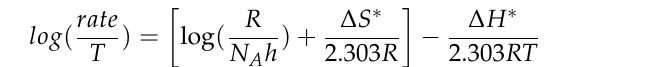
where Δ𝐼𝐸 ((cid:2871)(cid:2868)°(cid:2879)(cid:2874)(cid:2868)°)(cid:2887) % represents the overall decline in the IE % with increasing tempera- ture from 30 °C to 60 °C and may provide a good criterion for the stability and the perfor- mance of the inhibitors with temperature. The decrease in the inhibition efficiency was between 2.3% (FEAE) and 7.8% (ITAE), demonstrating the excellent corrosion protection of the plant extracts, particularly FEAE. These results indicate the formation of an organic protective film on the MS surface in which strong donor–acceptor interactions become important.